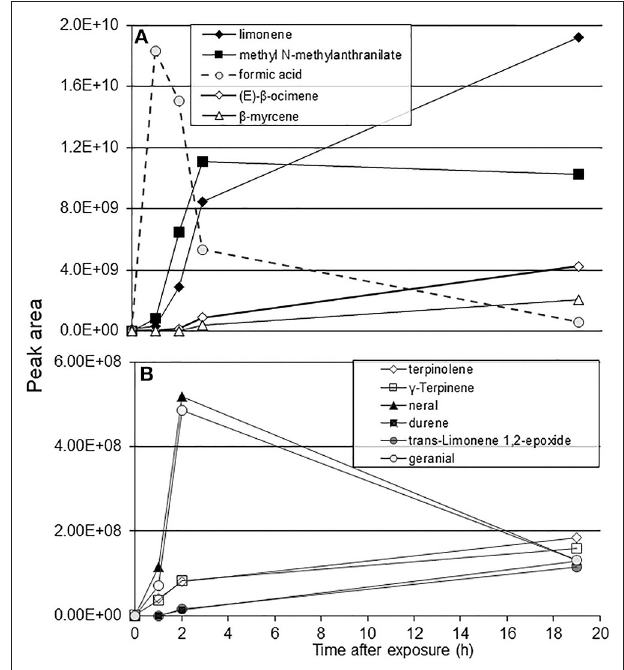
FIGURE 1 | SPME-GC/MS analysis of C. macrophylla volatile peaks following exposure to 50 µ L of formic acid for 1h. (A) peak area of major components; (B) peak area of additional citrus